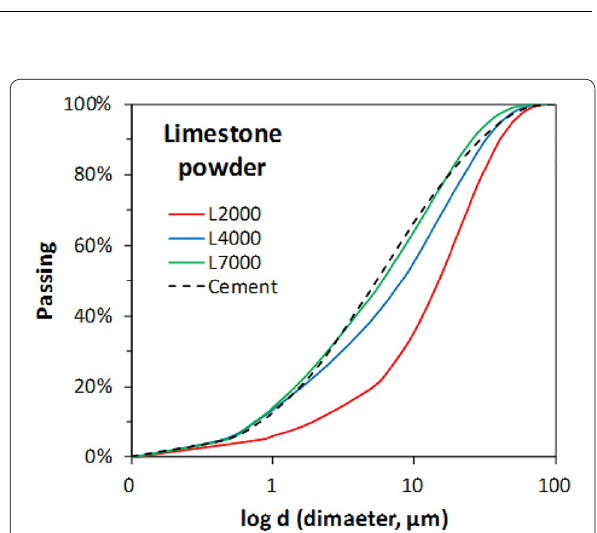
Fig. 1 Particle size distributions of the